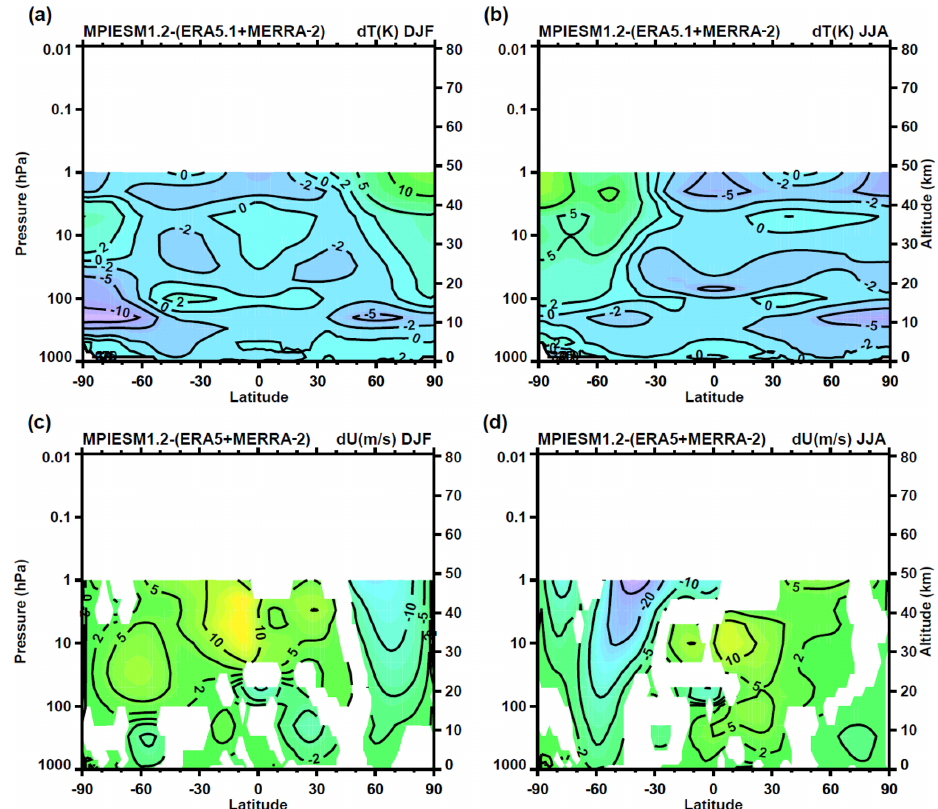
Figure A1. Zonal mean climatology differences between data simulated by MPI-ESM and the reanalysis data for temperature (a–b) and zonal wind (c–d) . White areas denote regions where the difference between model and reanalysis data is not statistically significant at the 95% confidence level calculated with a Student’s t